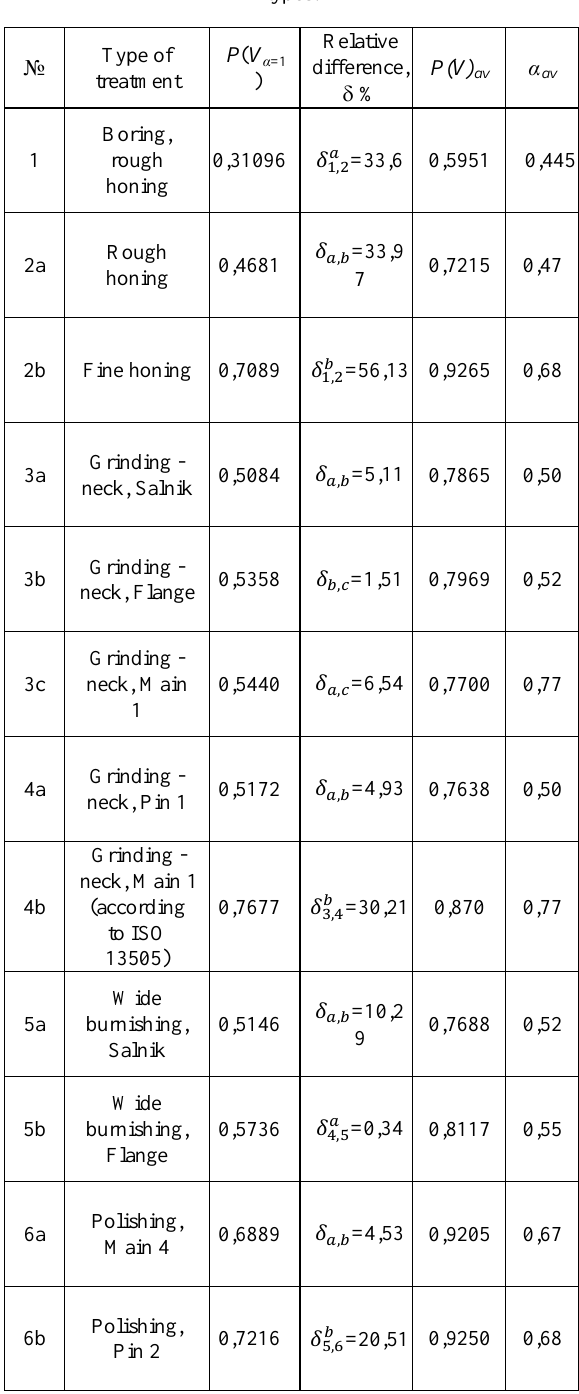
Table 4. Results of computational and graphic studies of surface texture probabilistic parameters for different processing